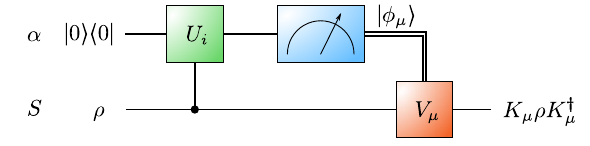
P i ih i j ⊗ ð U i Þ α S i j